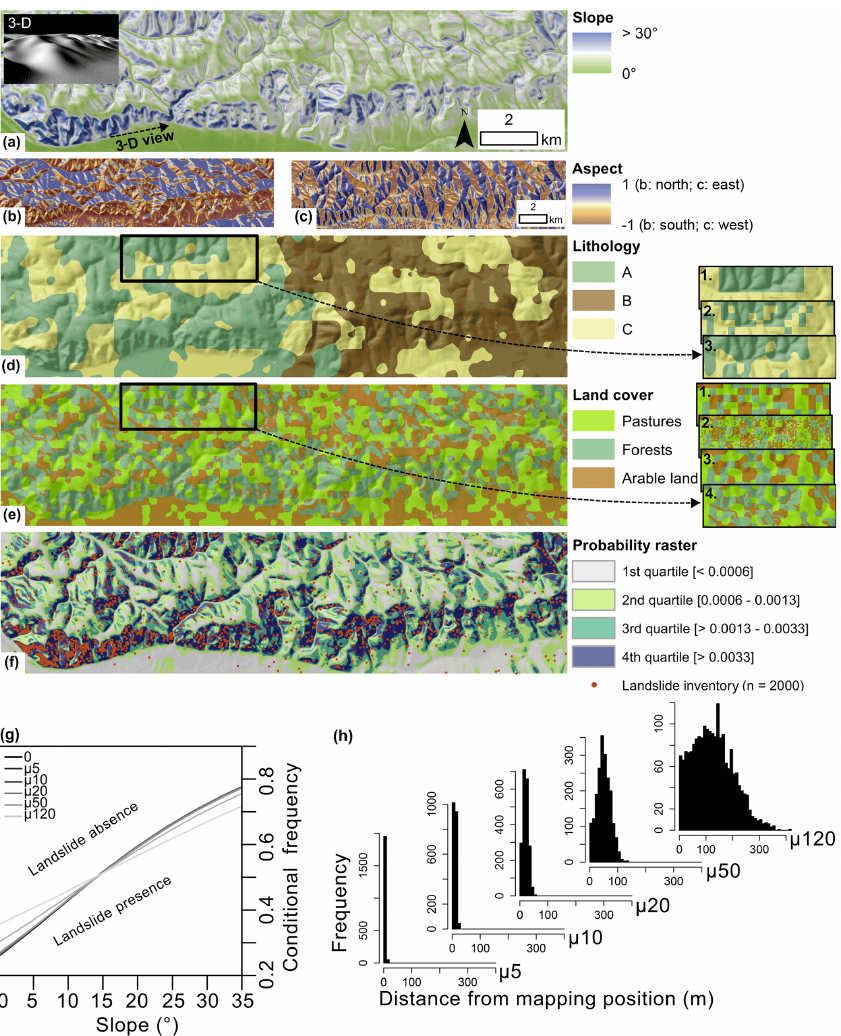
Figure 3. Spatial representation of the synthetically generated data set. Topographic parameters (a, b, c) ; Lithological and land cover units (d, e) with excerpts depicting the generation of this data sets (1: initial random raster; 2: intersection with a random raster produced at a higher spatial resolution; 3: moving window-based smoothing; 4: introduction of a slope-dependency for land cover). Landslide susceptibility according the predefined relationship and subsequent landslide sample further used as landslide presences for model realizations (f) . The plot in (g) depicts the conditional frequency of landslide occurrence on slope angle for the respective inventories. The histograms in (h) (bin width 10m) show the frequency of landslides ( n = 2000) in relation to the distance from the original mapping position.